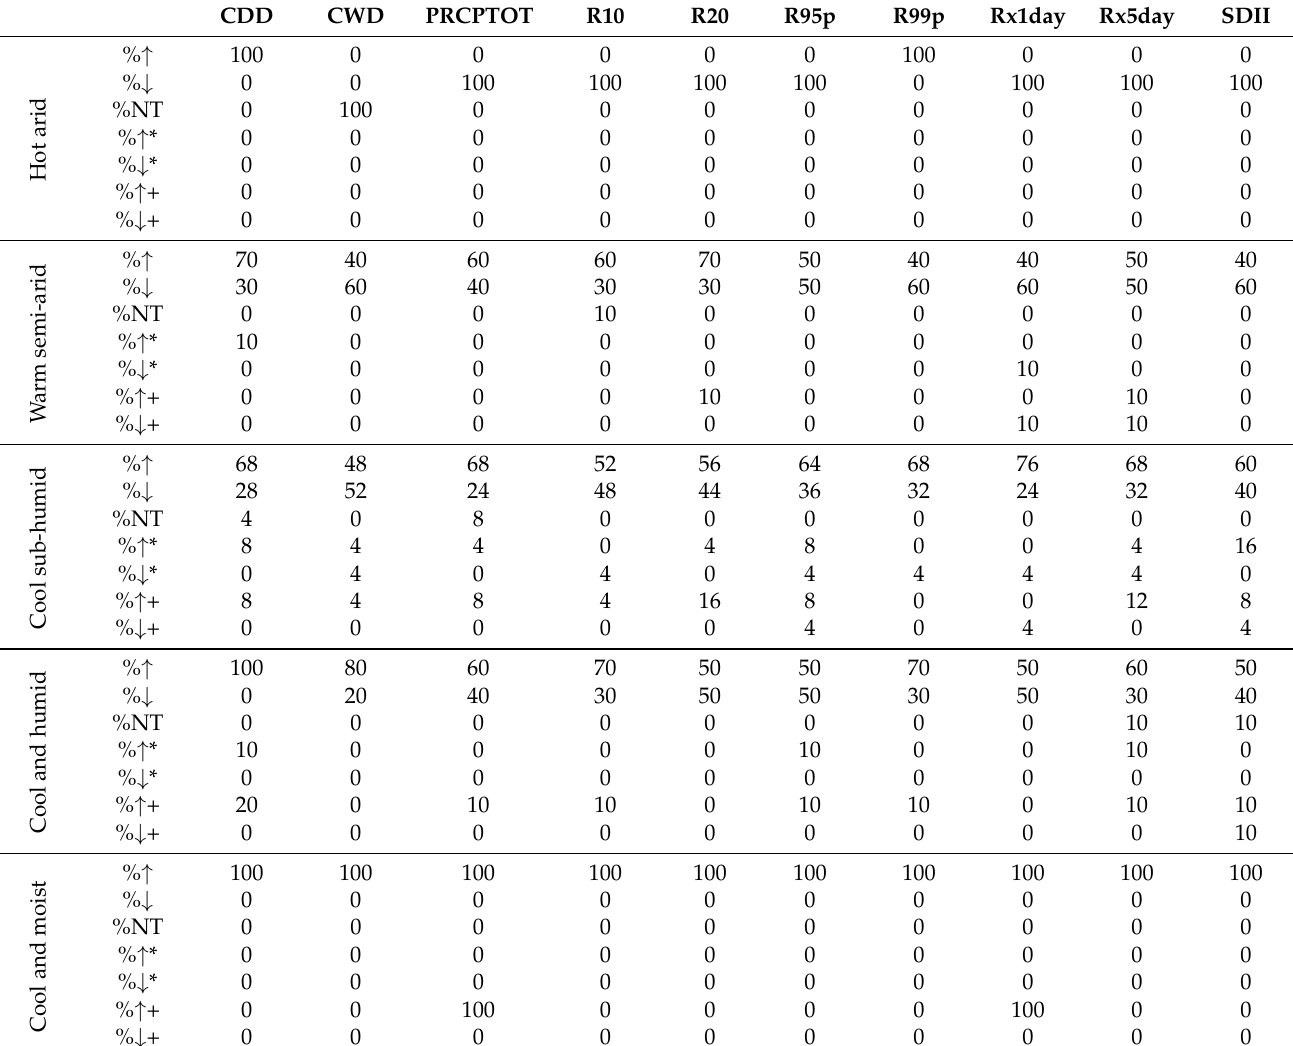
Table 5. The trends of extreme rainfall indices in different AEZs of